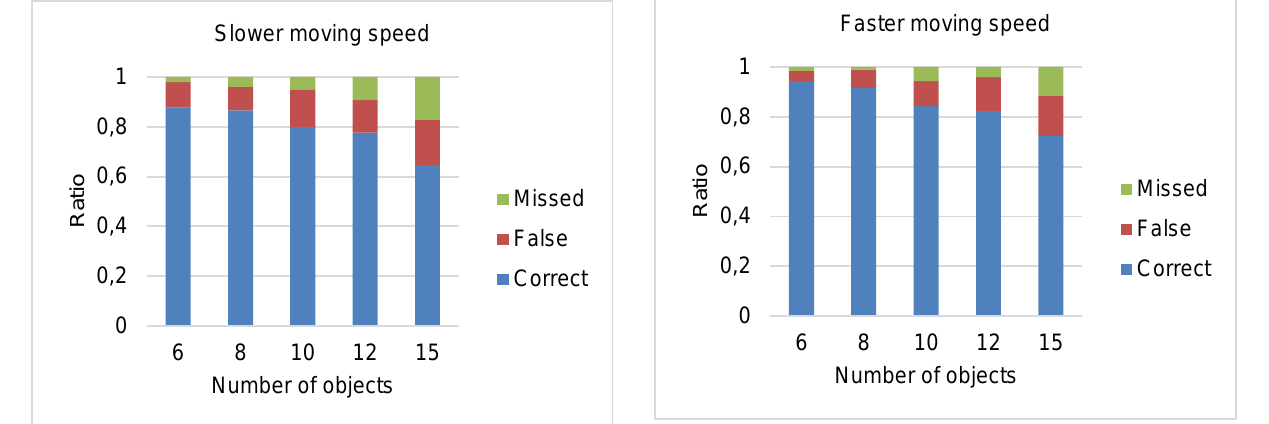
Figure 6: Ratio of detection rates for slower moving speed